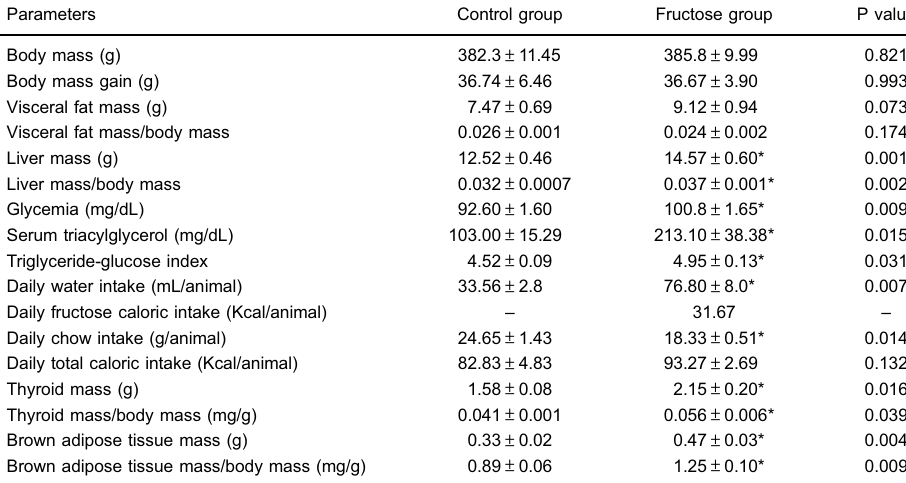
Table 1. Metabolic parameters of animals of the control group and fructose group after 3 weeks of treatment.